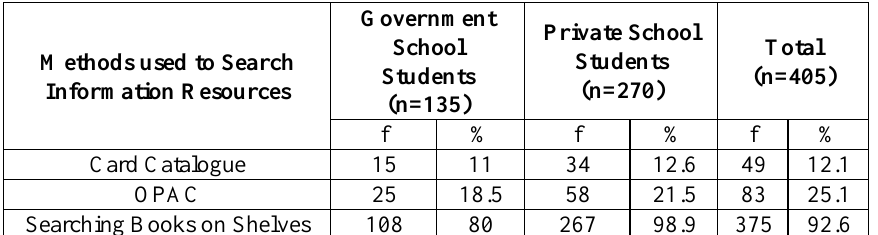
Table 4- Methods Used to Search Information Resources